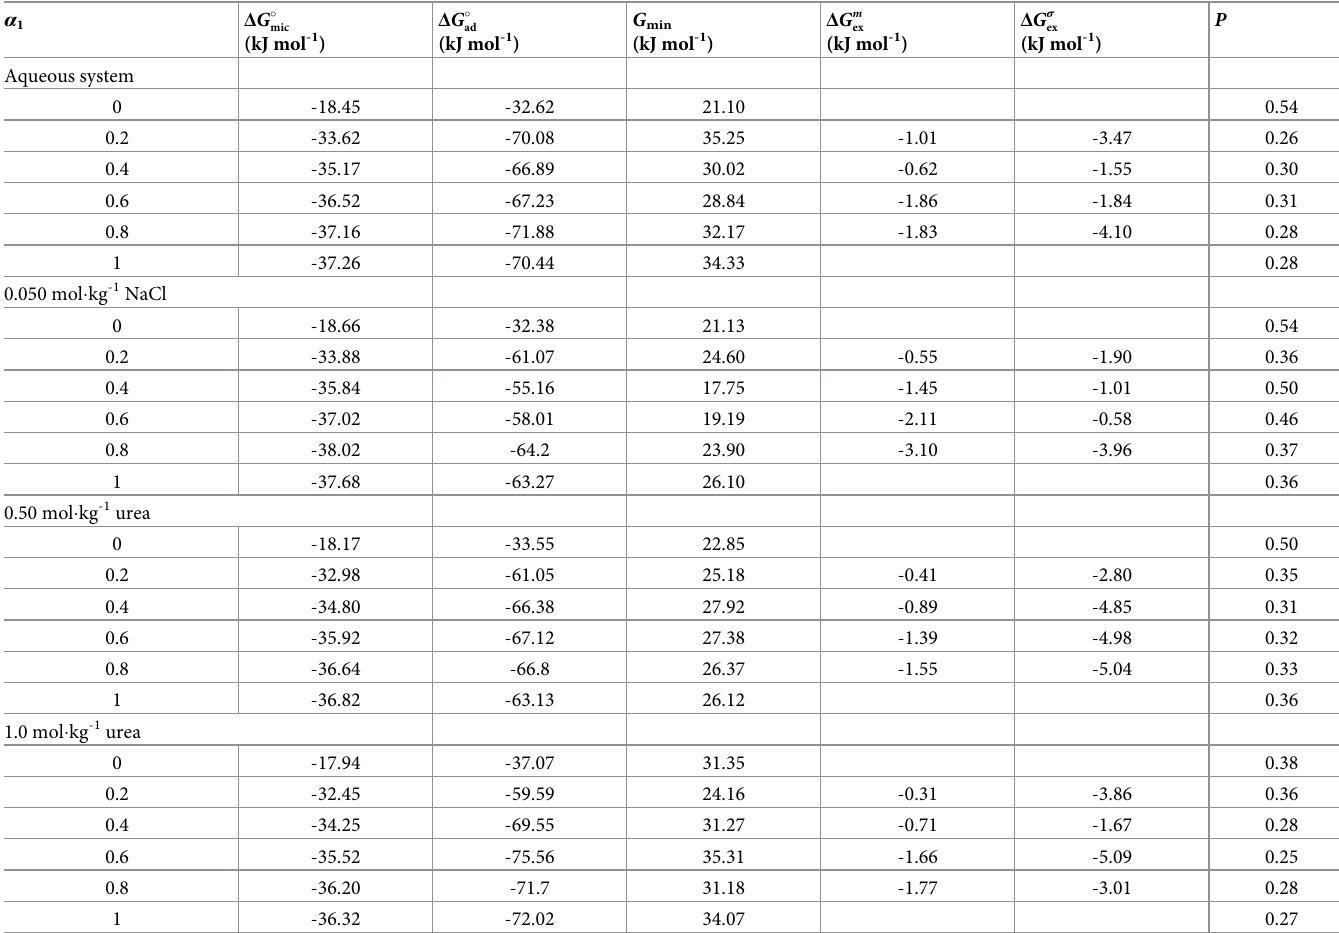
Table 3. Different thermodynamic parameters and packing parameter ( P ) for AMT-14-E2-14 mixed system in diverse solvent at 298.15